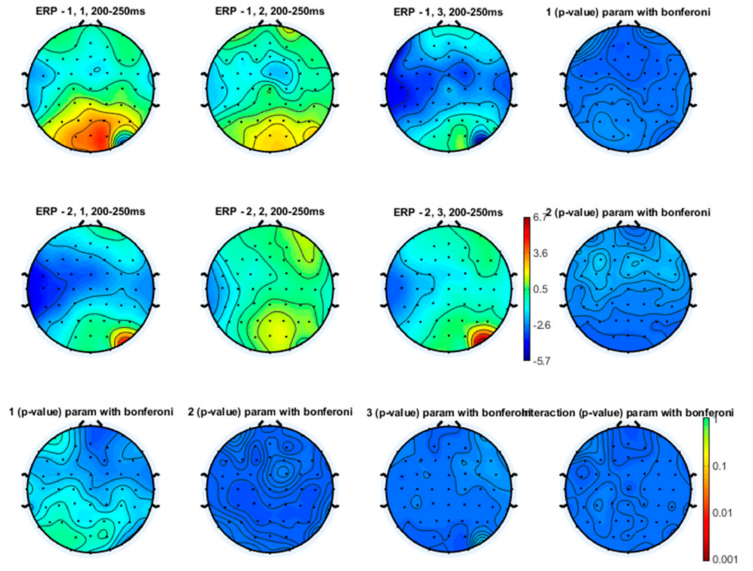
Figure 4. Topographical representation of the N2 component on the right hand stimulation. The first line of topographical maps represents the N2 amplitude in the baseline condition, slow finger tapping (SFT) and fast finger tapping (FFT) in the control group. The second line of maps represents the N2 amplitude in the baseline condition, slow finger tapping (SFT) and fast finger tapping (FFT) in the patient group. The control group’s basal condition (1,1), slow finger tapping (1,2) and fast finger tapping (1,3); the fibromyalgia (FM) group’s basal condition (2,1), slow finger tapping (2,2) and fast finger tapping (2,3) (see also Figure 1). The results of the repeated measures analysis of variance (ANOVA) corrected with the Bonferroni test are